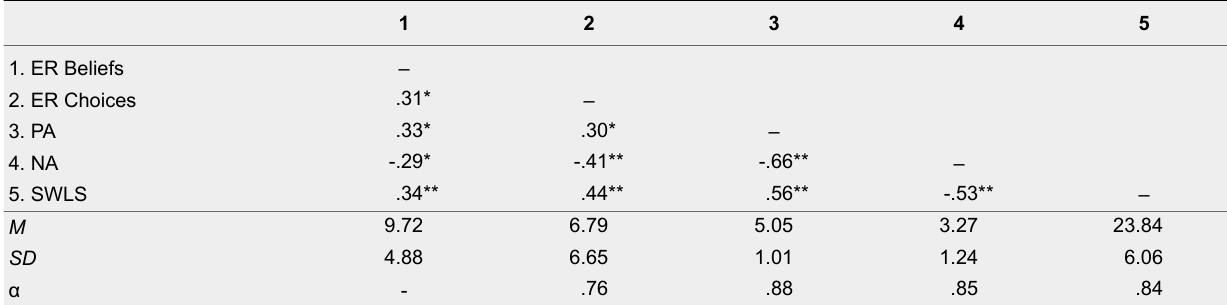
Descriptive Statistics (Means, Standard Deviations, and Cronbach’s Alpha) and Pearson Correlation Coefficients Among Emotion Regulation Beliefs, Choices, and Subjective